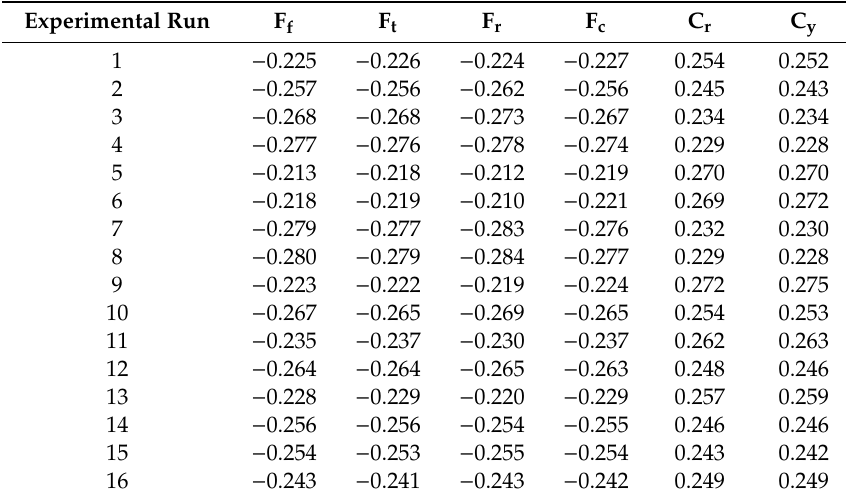
Table 6. Normalization of signal to noise ratios of responses.